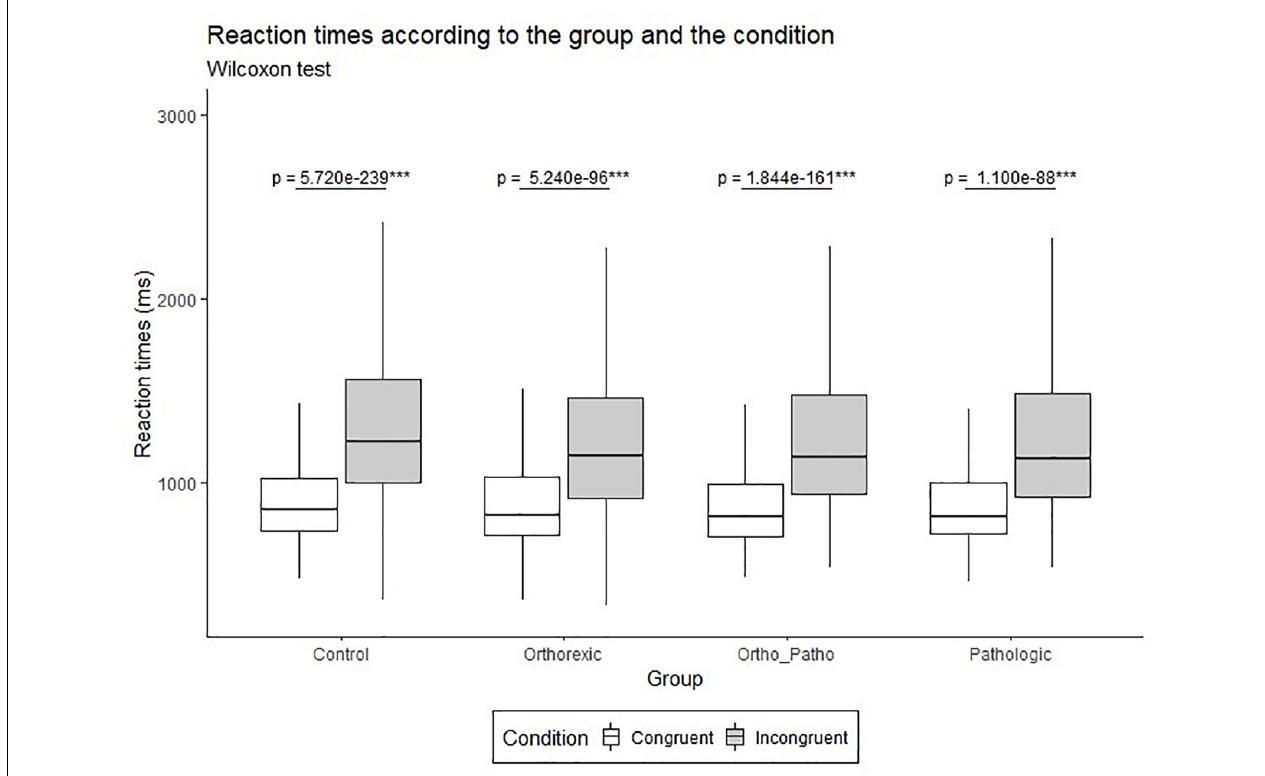
FIGURE 4 | RT (ms) according to the group and the condition with Wilcoxon-test p -value results. ***Indicates significant differences between congruent and incongruent